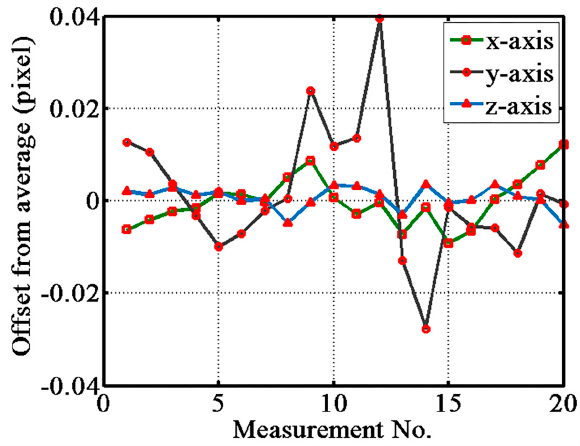
Figure 9. Repeatability results along the x, y, and z